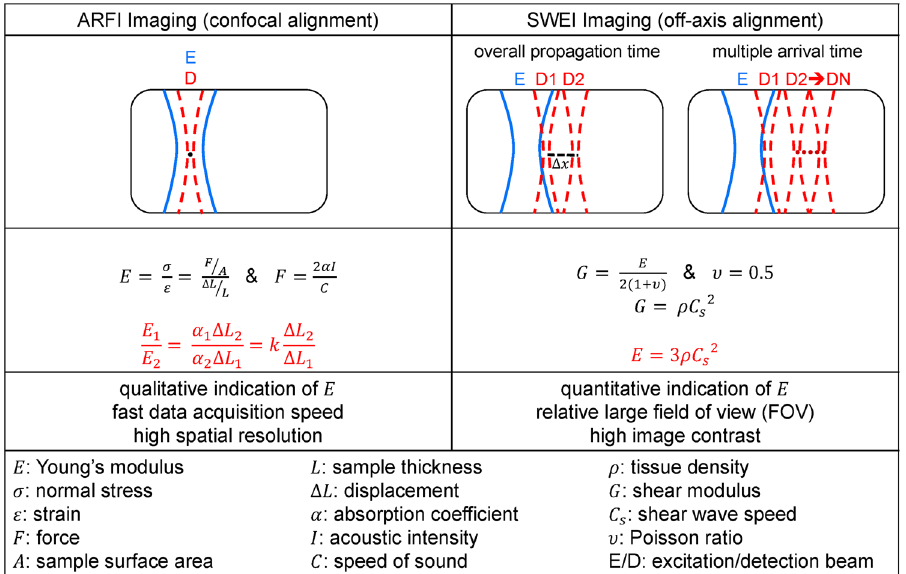
Figure 7. The principle comparison and analysis of ARFI and